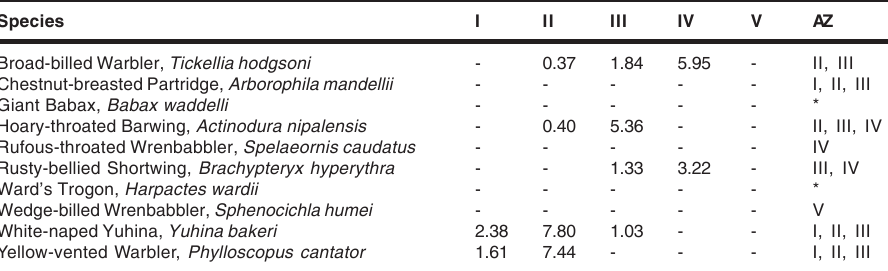
AZ - reported altitude zone for species; - - denotes species not observed during the present study; * - distribution of species not known.